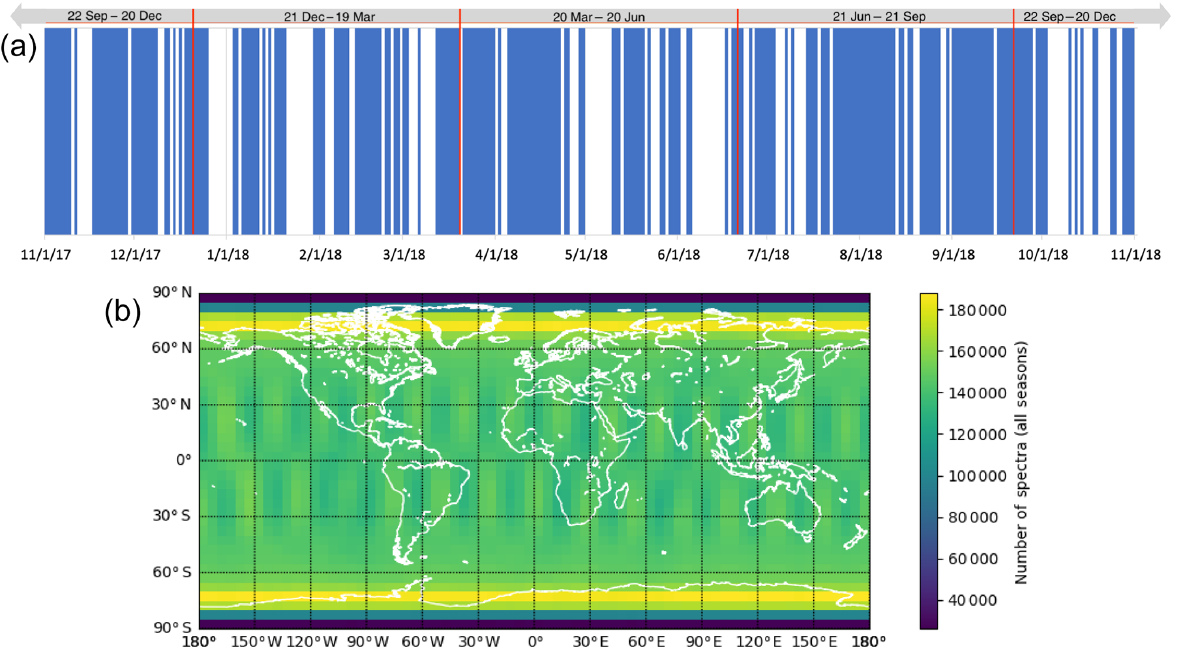
Figure 3. (a) IASI-derived days with (blue) and without (white) SO 2 columns with VCD ≥ 1DU in the 1-year background construction interval (1 November 2017–1 November 2018). Date intervals across the top define the seasons. (b) Histogram showing the number of SNPP CrIS spectra in each latitude–longitude cell totaled over the 1-year